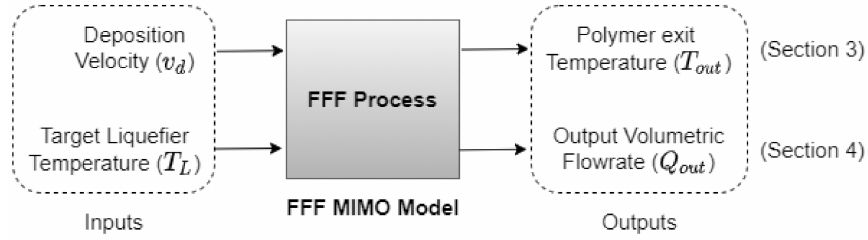
Figure 1. FFF multi-input multi-output (MIMO) model to represent process